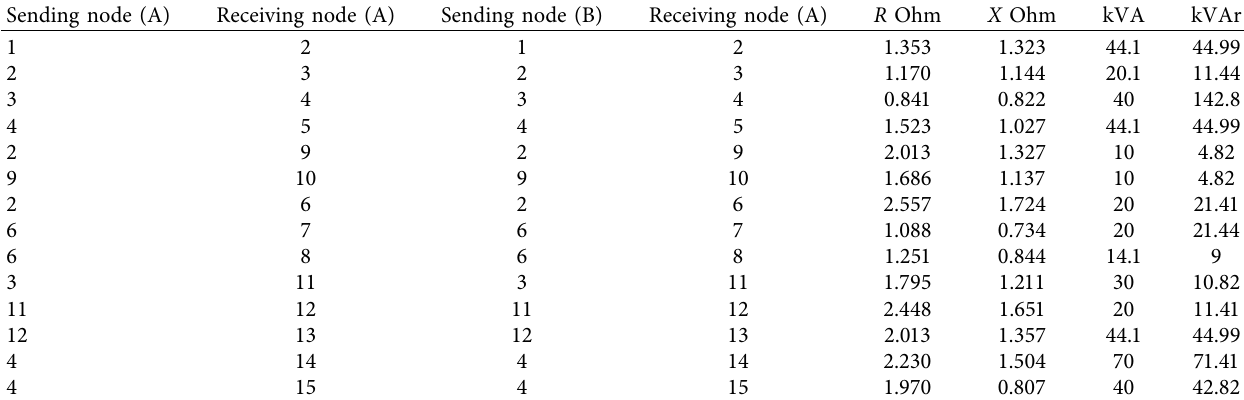
Table 2: Load data and line data of the two meshed feeders A and B (feeder A and feeder B are identical). Sending node